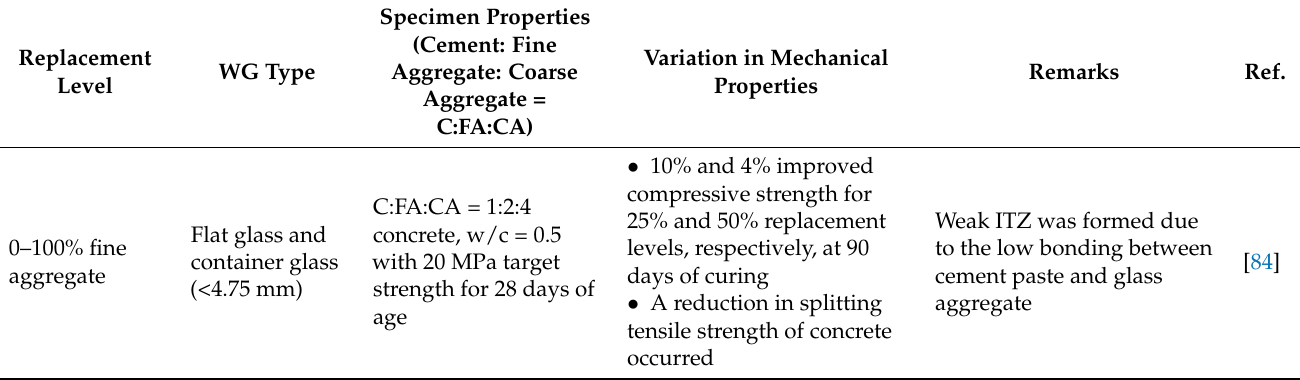
Table 4. Summary of the mechanical properties of